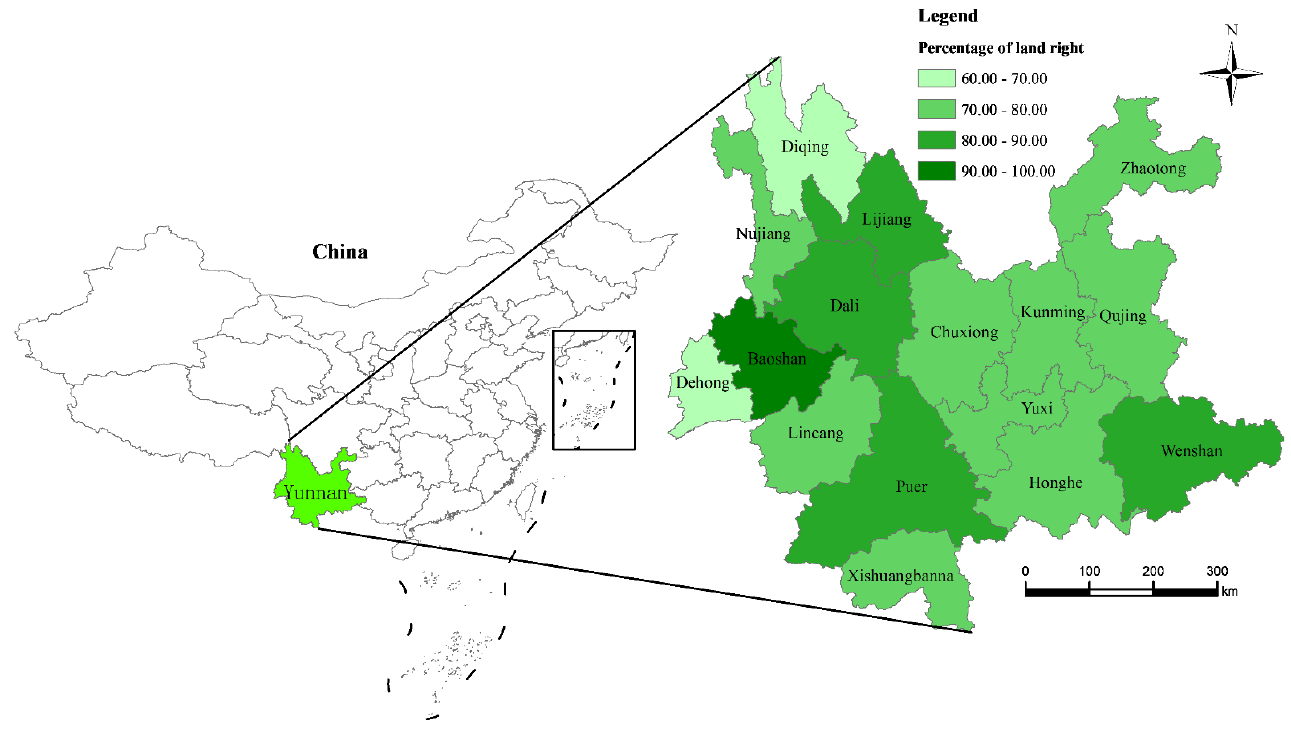
Figure 1. The study area covers the whole Yunnan Province in China. Colored areas show the percentage of the rural land right of cities (prefectures). Table 1. Distribution of